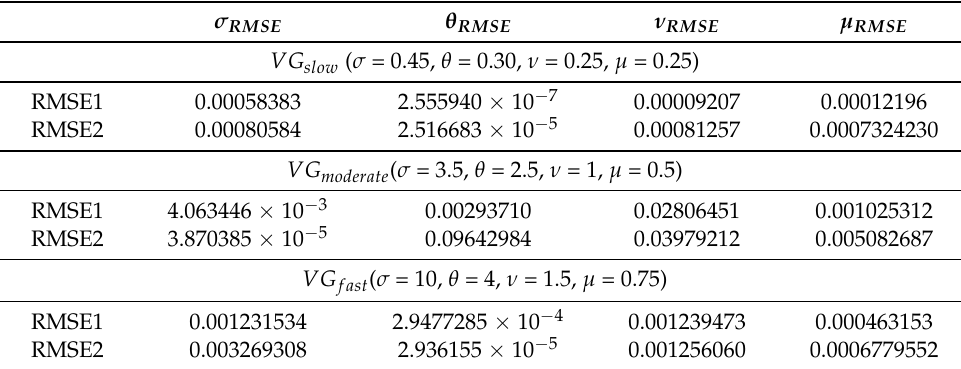
Table 4. RMSE for different type of trajectories.